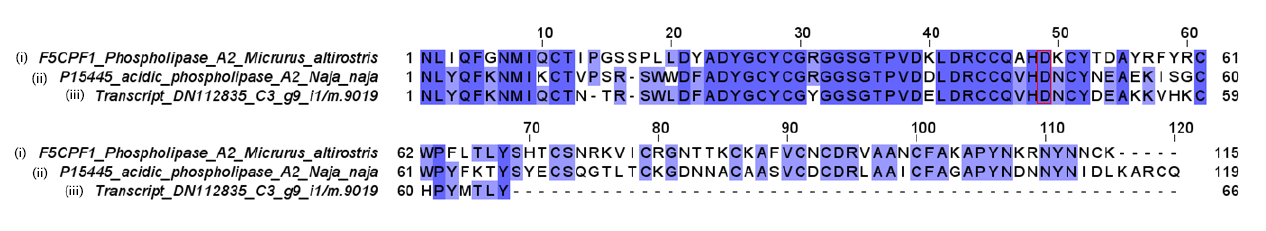
Figure 2. The sequence of two known snake venom phospholipases, (i) phospholipase A2 ( M. altirostris – UniProtKB F5CPF1) and (ii) acidic phospholipase A2 ( N. naja – UniProtKB P15445), were aligned against the identified protein sequence (iii) transcript ID DN112835_C3_g9_i1/m.9019 using Clustal O (1.2.4) multiple sequence alignment. The blue scale color showed the similarity between each sequence. Dark blue: all sequences have the same amino acid in this position; light blue: two sequences have the same amino acid in this position. It is possible to observe the similarity between the sequence DN112835_C3_g9_i1/m.9019 and the other two phospholipase sequences. Aspartate at position 49, which is characteristic of a PLA